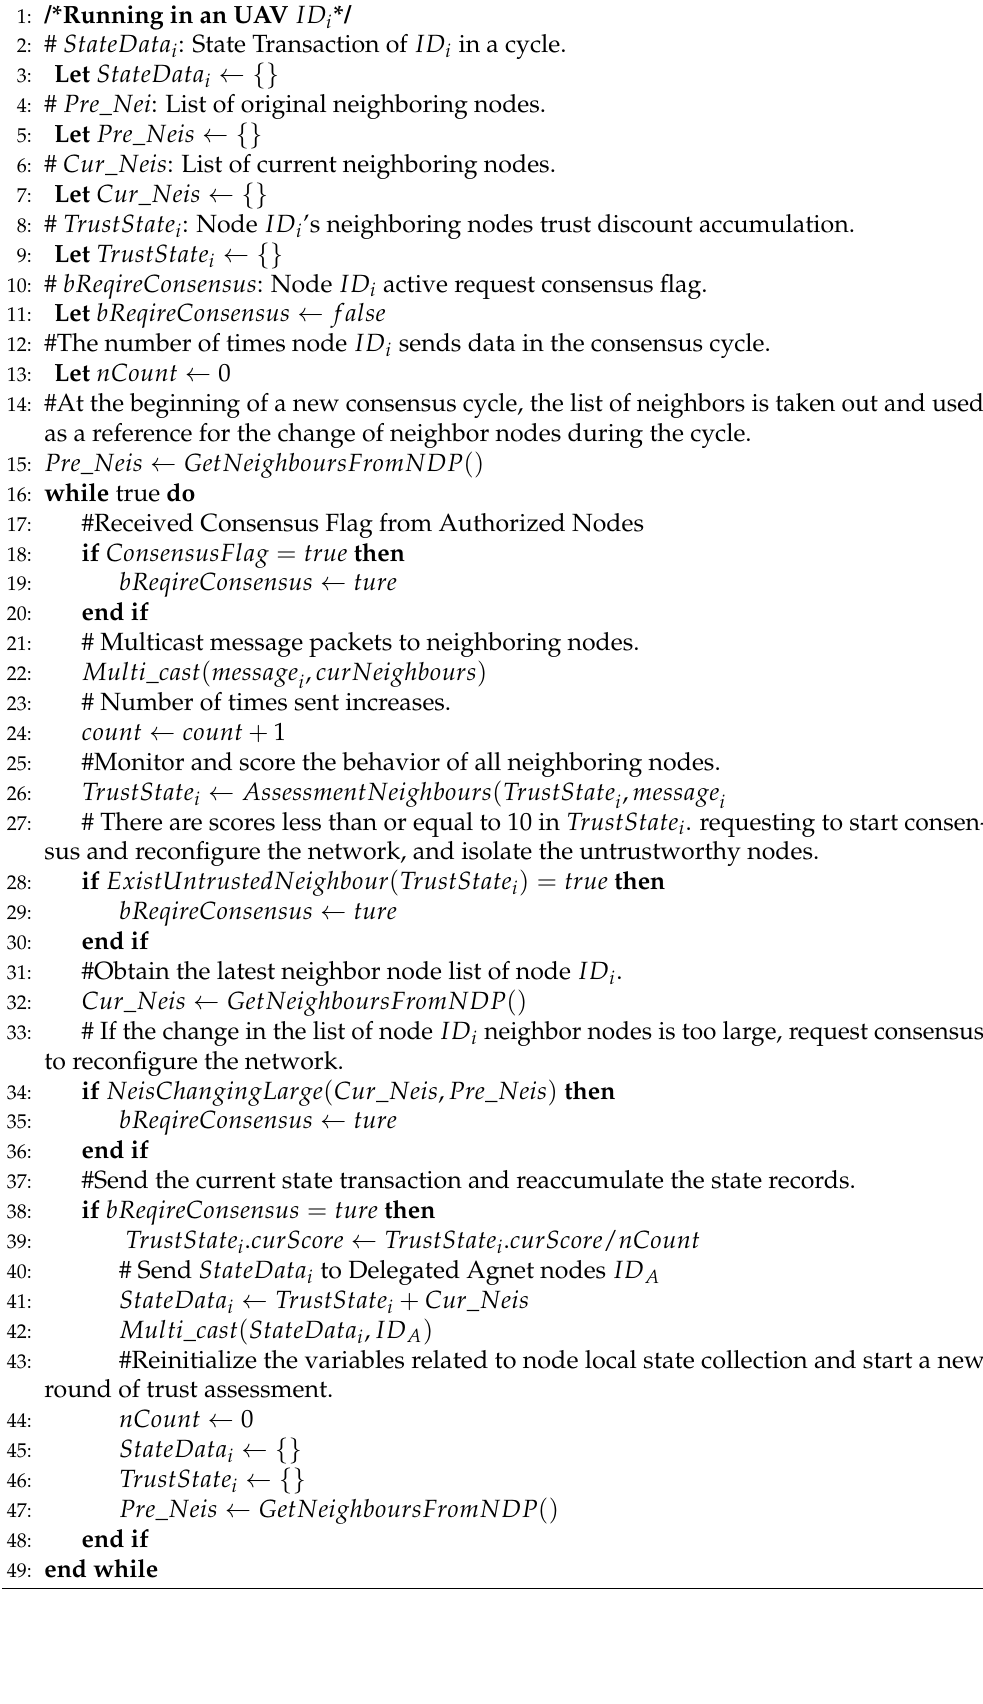
Algorithm 2 Local State Transactions Generating for Node ID i